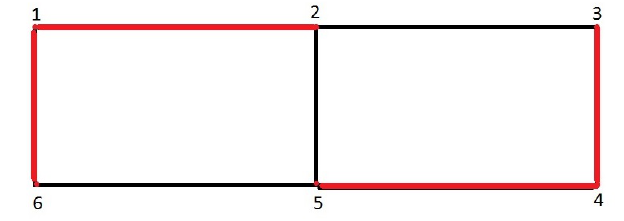
Figure 3. Graph packing by vertex